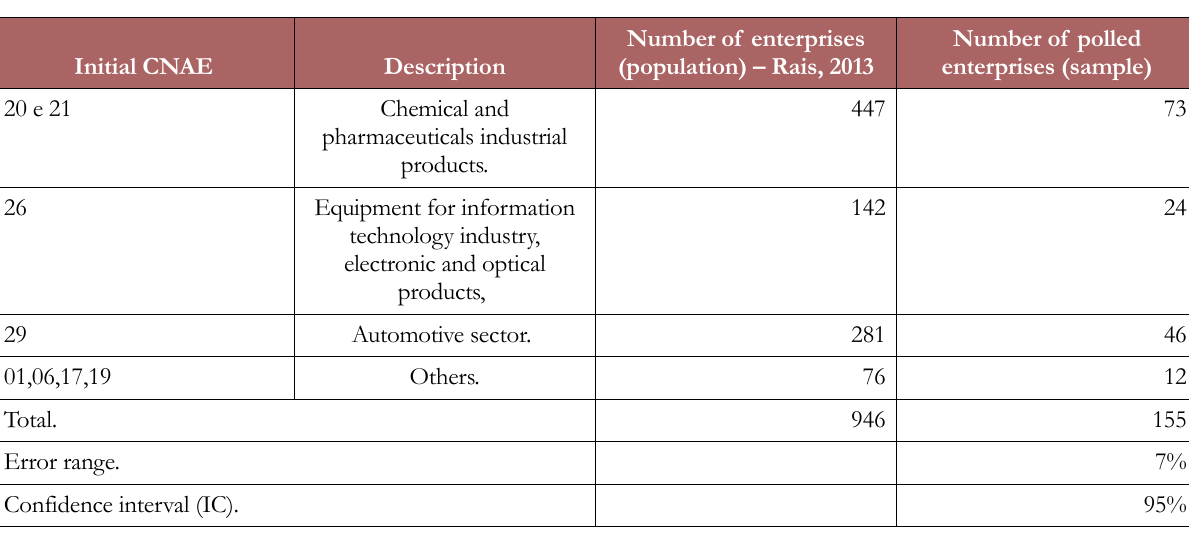
Table 3. Characteristics of innovative enterprises in Minas Gerais (Own elaboration, with Marcolino de Lima’s support, 2015)